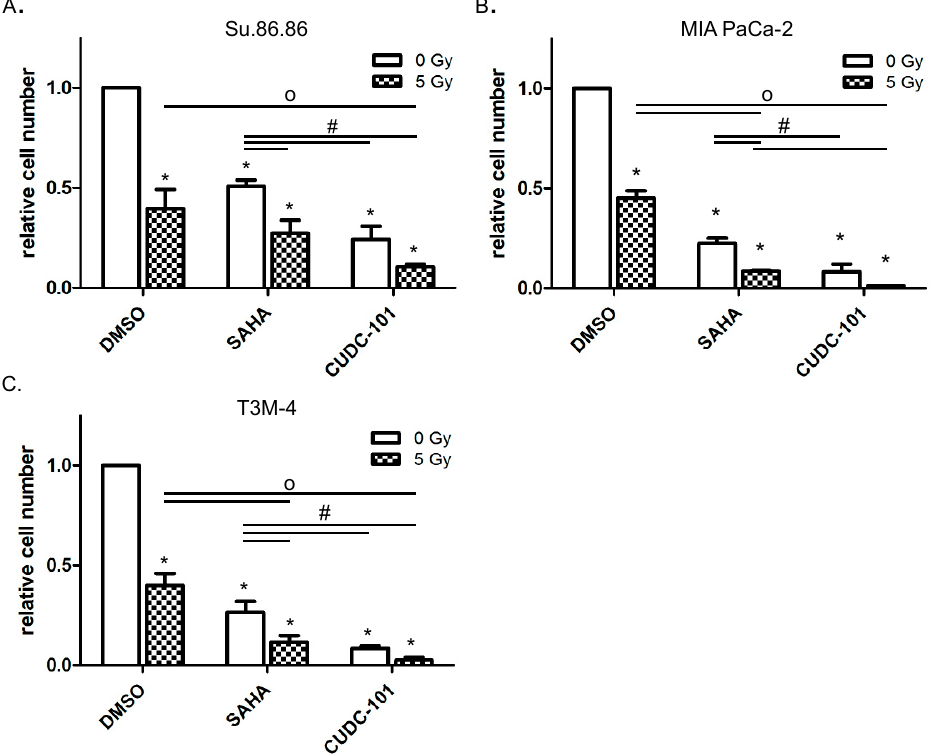
Figure 1. CUDC-101 more efficiently blocked proliferation than SAHA. Pancreatic cancer cell lines Su.86.86 ( A ), MIA Paca-2 ( B ) and T3M-4 ( C ) cells were treated with SAHA (1.5 µM) or CUDC-101 (0.5 µM) for 24 h, then cells were irradiated with 5 Gy or sham irradiated. After another 72 h cells were harvested and cell numbers were determined by counting. Histograms show the mean ± SEM of three independent experiments. For statistical analysis ANOVA was performed with post hoc Bonferroni multiple comparisons. * Indicates comparison with DMSO control, p < 0.01; # indicates comparison between SAHA and CUDC-101, p < 0.05; o indicates comparison between irradiated samples, p < 0.05.